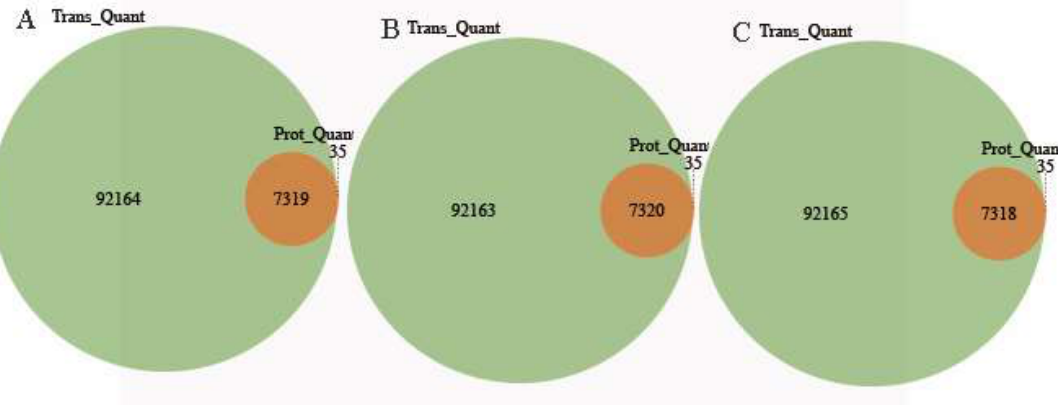
Figure 6. Congruency of the detected transcriptome and proteomein each different stage (A, S1/S0; B, S2/S1 and C, S3/S2).